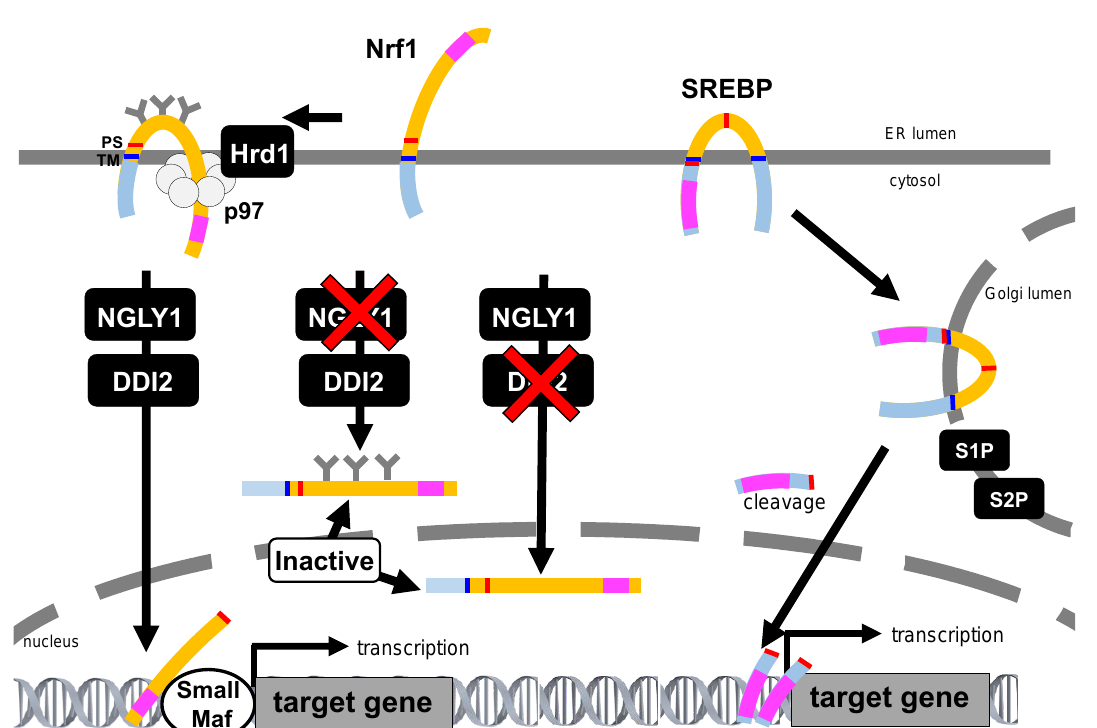
Figure 4. Comparison of Nrf1 and sterol regulatory element-binding protein (SREBP) activation pathway. The SREBP precursor is inserted into the ER, and both the amino-terminal transcription factor domain and the carboxyl-terminal regulatory domain are located in the cytoplasmic compartment. When the cellular demand for sterols rises, the SREBP precursor protein travels to the Golgi apparatus and is processed by site-1 protease (S1P) and site-2 protease (S2P). Then, the transcription factor domain released from the membrane enters the nucleus and induces the transcription of target genes. In contrast, the transcription activation domain of Nrf1 is initially in the ER lumen, which is topologically distinct to SREBP and other ER-resident transcription. Inhibition of NGLY1 results in the accumulation of glycosylated, unprocessed Nrf1. Inhibition of DDI2 leads the generation of a deglycosylated but unprocessed DDI2 that enters the nucleus while inactive. Thus, Nrf1 needs the proper sequential treatment for its activation. The transcription activation domain is represented as pink square. TM: transmembrane, PS: processing site. DDI2 was identified as a Nrf1 nuclear translocation regulator by an image-based screening of mammalian cells [91]. By genetic screening using C. elegans , ddi1 ( C. elegans ortholog of DDI2) mutants were identified as having suppressed SKN-1-dependent induction of proteasome gene expression [92]. DDI family proteins consist of a retroviral protease-like (RVP) domain that exhibits a structure closely resembling that of the HIV protease-1, suggesting that DDI proteins are aspartic proteases. In fact, a mutation in the protease active site of DDI2 decreased the production of the ≈ 110 kDa processed form of Nrf1, whereas the ≈ 120 kDa full-length form of Nrf1 was accumulated. Additionally, the bounce-back response of proteasome expression against proteasome inhibition was remarkably suppressed by DDI2 depletion and in protease-dead DDI2 mutants in both C. elegans and mammals. This indicates that the activation mechanism of Nrf1/SKN-1 by the DDI proteins is widely conserved in multicellular animals.